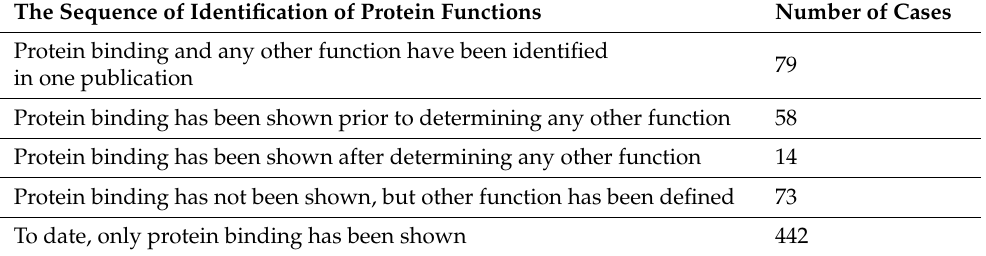
Table 3. The sequence of identification of protein functions related to binding to other proteins is estimated according to neXtProt using a selection of identified functions and evidence such as direct assay evidence used in manual assertion and physical interaction evidence used in manual assertion, referencing journal articles from 2016 to